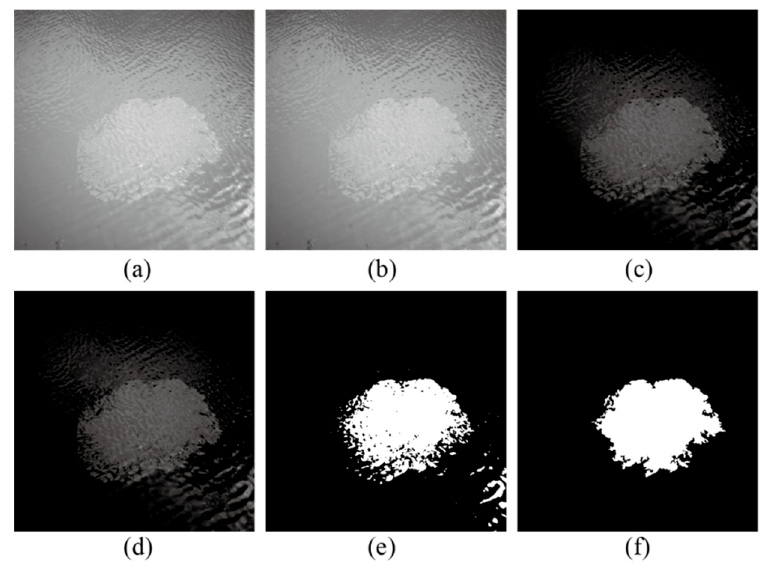
Figure 10. Segmentation result of a target with low contrast and waves. ( a ) The original image; ( b ) the preprocessed image; ( c ) the result using GBS; ( d ) the result using ATE; ( e ) the segmentation result with LFTM; and ( f ) the final segmentation result.